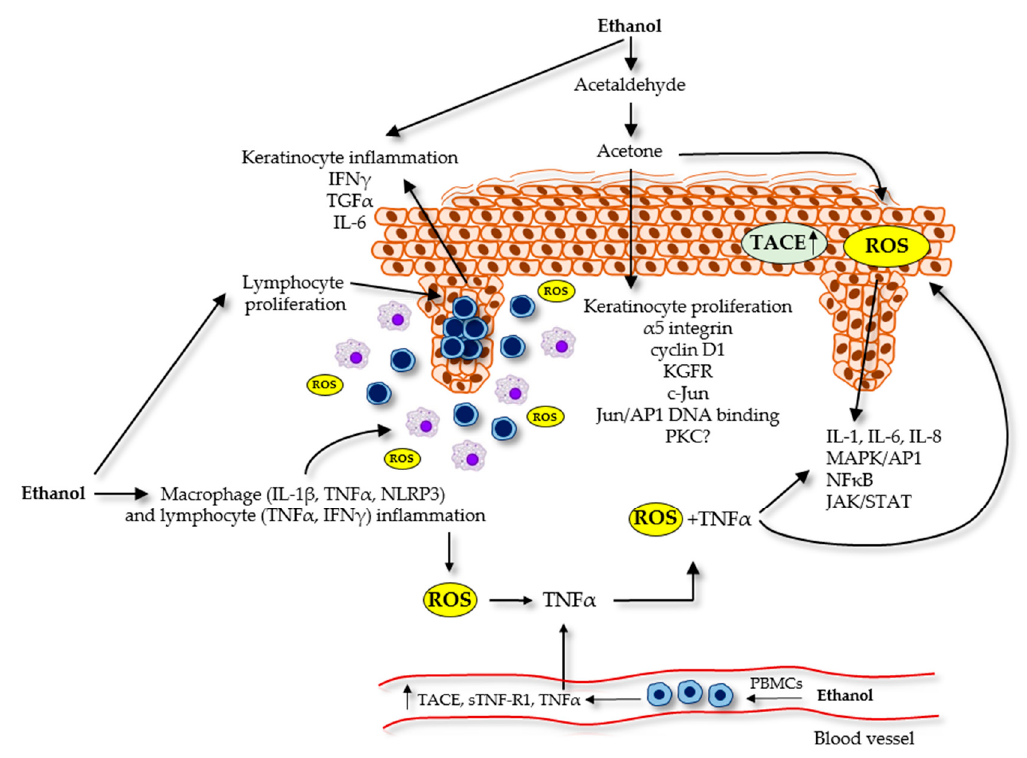
Figure 1. Overview of the potential role of ethanol and its metabolites at the cellular level in the pathomechanism of psoriasis. Ethanol and acetone increase the proliferation and mRNA expression of proliferation-associated genes in keratinocytes and disrupt skin barrier function. Ethanol and ROS formed during ethanol metabolism generate an inflammatory environment and trigger psoriasis by regulating different signal transduction pathways and inducing the production of various pro-inflammatory cytokines in lymphocytes, macrophages and keratinocytes. Excessive alcohol consumption may contribute to increased TACE expression in PBMCs and, in consequence, to elevated plasma sTNF-R1 and TNF α concentrations in patients with psoriasis.